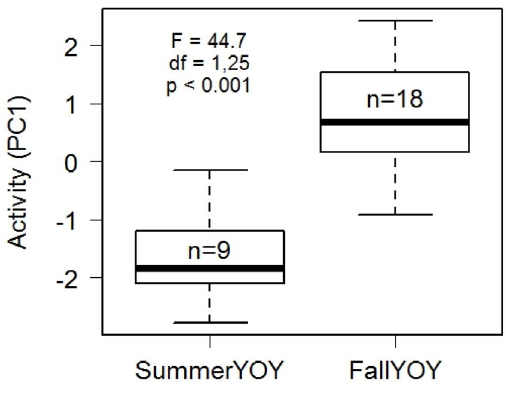
Figure 3. Comparison of activity levels for 28 YOY little brown bats captured at a maternity colony (summer YOY, n=9) and a hibernaculum (fall YOY, n=18) in August of 2009.